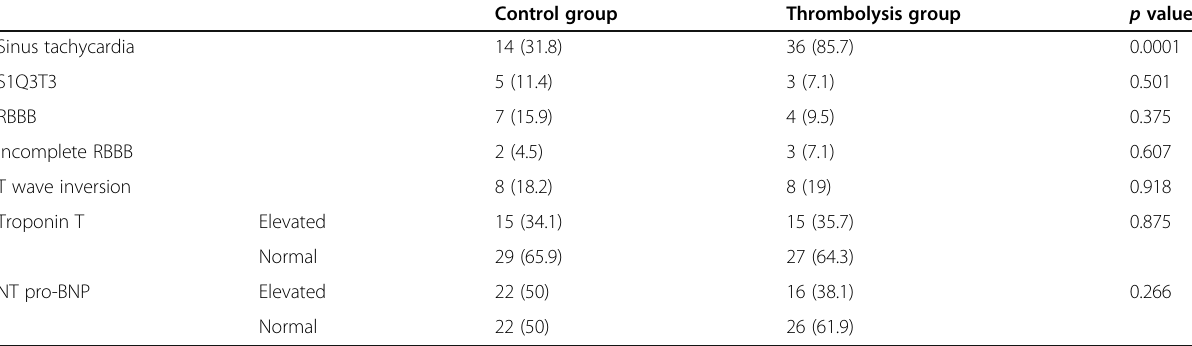
Table 3 ECG abnormalities in the study and the control groups